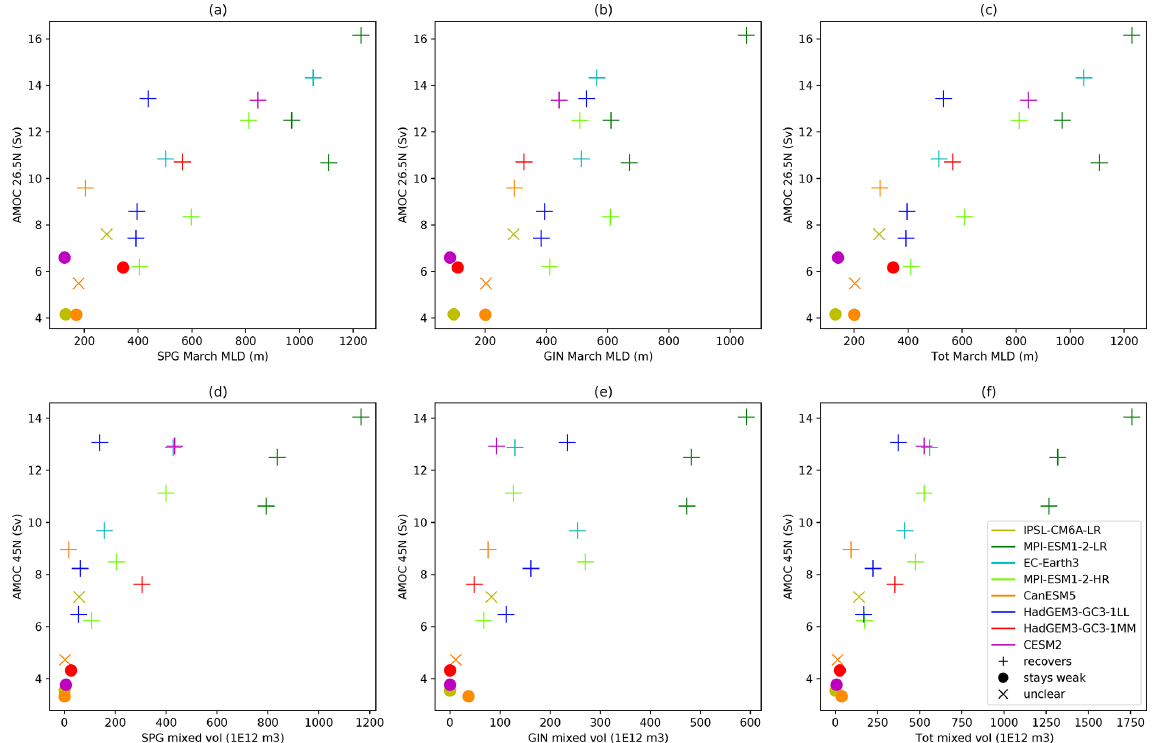
Figure 7. Scatter plots of decadal means from the decade before hosing stops. Top panels: AMOC at 26.5 ◦ N against maximum mean March MLD over (a) the subpolar gyre (80 ◦ W–20 ◦ E, 50–65 ◦ N), (b) the GIN seas (50 ◦ W–40 ◦ E, 65–80 ◦ N), and (c) the whole region (80 ◦ W– 40 ◦ E, 50–80 ◦ N). (d) – (f) As (a) – (c) but for the AMOC at 45 ◦ N against the mixed volume (defined as the volume above the mixed-layer depth and below